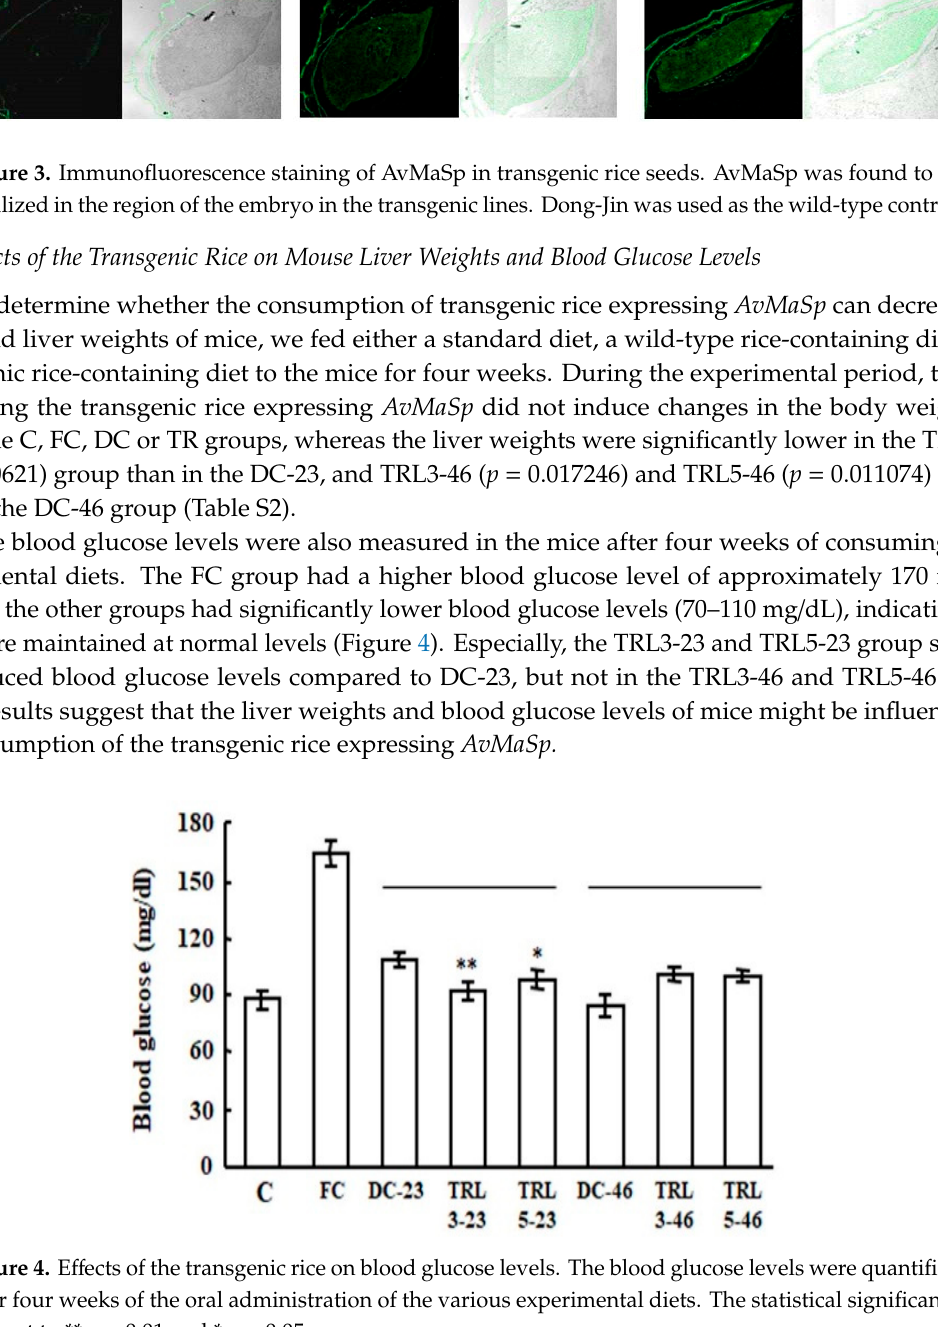
quantified after four weeks of the oral administration of the various experimental diets. The statistical